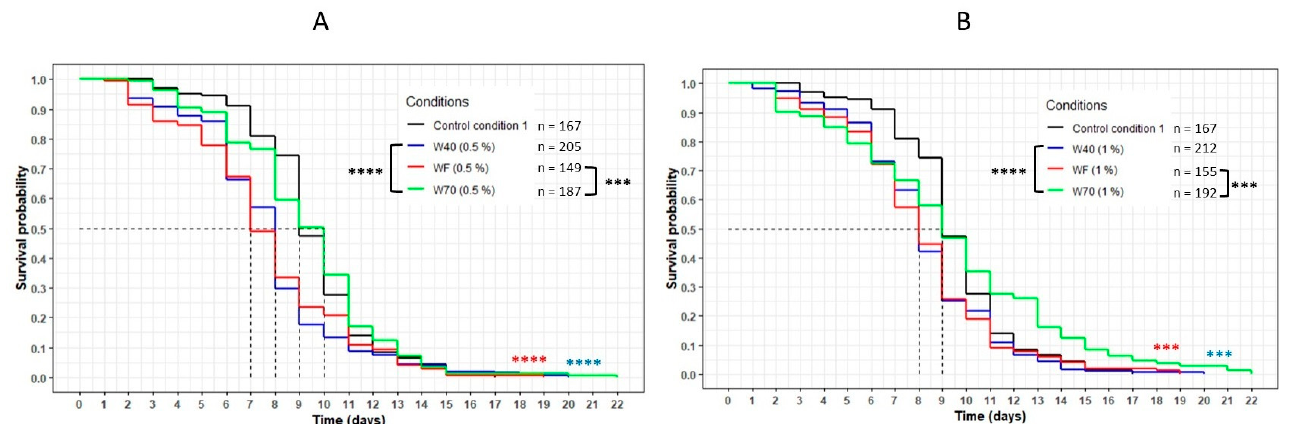
Figure 4. Comparison of the effect of the aqueous extracts WF, W40 and W70 at 0.5% ( A ) and 1% ( B ) concentration on the C. elegans GR1307 strain lifespan. The worms were incubated on the medium supplemented with the dried extracts obtained with water at day 0 and regularly fed with HK E. coli OP50. The conditions were considered significantly different when the p -value was lower than 0.001 (***) or 0.0001 (****) (log-rank test). The asterisks next to the curves represent the differences with the control condition CC1. The asterisks next to the legend represent the differences between the extracts.